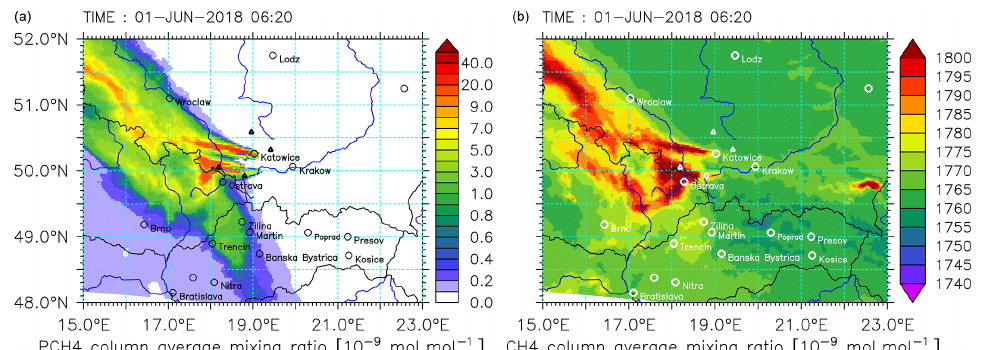
Figure 6. Snapshot of the methane forecasts during CoMet 1.0 simulated with the finest-resolved COSMO/MESSy instance CM2.8. The total-column dry-air average mixing ratio in micromoles per mole (µmolmol − 1 ) is calculated for PCH4 (a) and CH4_FX (b) . The area encompasses the USCB and shows the evolution of methane plumes in the atmosphere. Note that the colour bar on the left is pseudo- logarithmic for better visualization. Table 2. Summary of the results of the statistical analysis of C1 and C2 compared to the simulated X fl CH4. Listed are the root mean square error (RMSE) in micromoles per mole (µmolmol − 1 ), the normalized mean bias error (NMBE) in percent and the correlation coefficient ( R ) for the model domains CM7 and CM2.8. Flight RMSE RMSE NMBE NMBE R R (CM7) (CM2.8) (CM7) (CM2.8) (CM7) (CM2.8) C1 0.08 0.08 − 4 . 1 − 4 . 2 0.47 0.47 C2 0.10 0.10 − 5 . 3 − 5 . 3 0.75